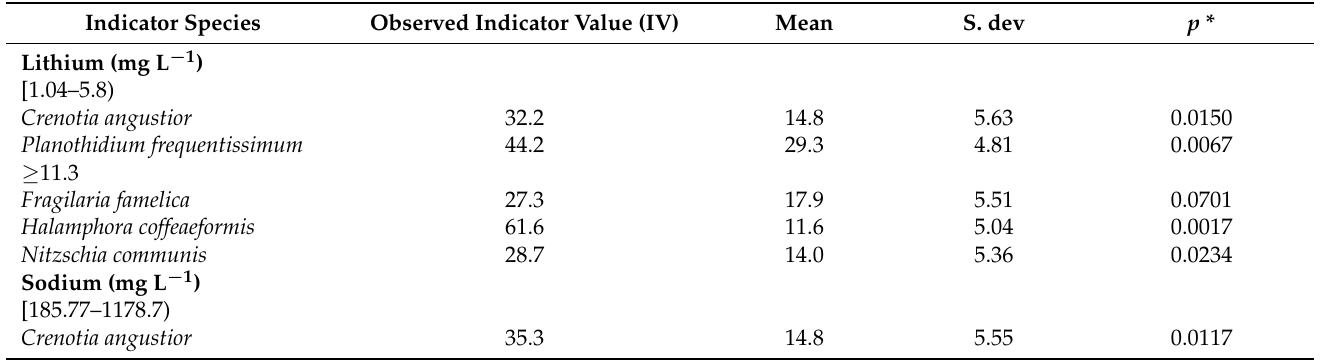
Figure 11. Box plots of the species richness made using the classes of the significant variables (using Kruskal–Wallis tests) of the studied springs. The red crosses represent the mean of data and the black bullets, the outlier points. Table 6. List of indicator species for concentration classes with an observed indicator value (IV) greater than 20%, along with mean standard deviation and significant p -values (* < 0.05). Different diatoms were linked to each